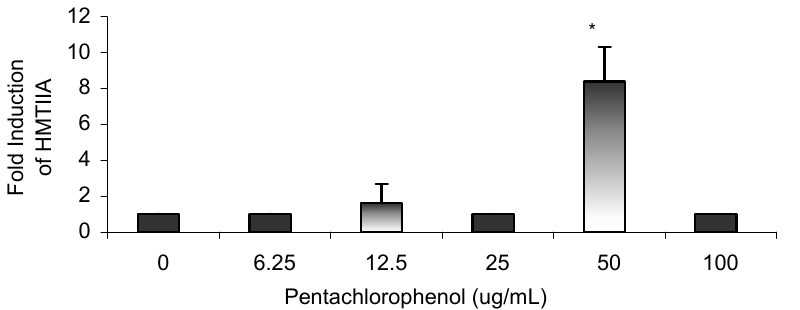
cells exposed to pentachlorophenol : Recombinant Figure 4. Fold induction of HMTIIA in HepG 2 cells transfected with a HMTIIA gene promoter fused to the CAT protein were treated with HepG 2 serial dilutions of PCP (0-100 µ g/mL). HMTIIA was based on the expression of the CAT-protein using a sandwich ELISA, and indicated in the methodology section. Bars are means + SDs, n=3. *Significantly different from control (0 µg/mL PCP), p <